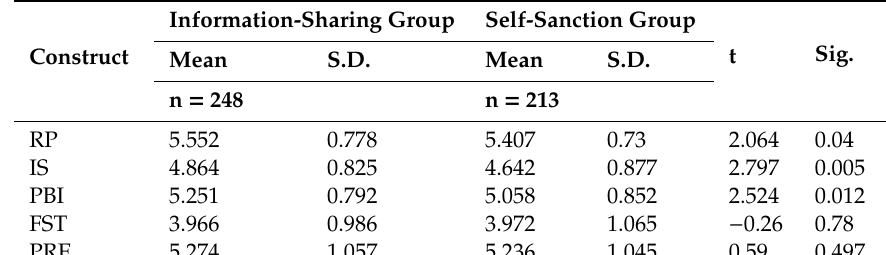
Table 5. Independent sample test between the two groups.